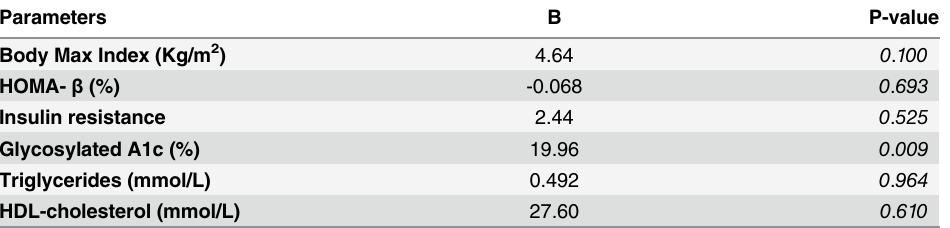
Table 4. Association of fasting serum levels of sCD26/DPP-IV with MetS and A1c levels among type 2 diabetes patients. Parameters B P-value Body Max Index (Kg/m 2 ) 4.64 0 . 100 HOMA- β (%) -0.068 0 . 693 Insulin resistance 2.44 0 . 525 Glycosylated A1c (%) 19.96 0 . 009 Triglycerides (mmol/L) 0.492 0 . 964 HDL-cholesterol (mmol/L) 27.60 0 . 610 The results are presented as unstandardized coef fi cients; B and (P-value) assessed using multiple linear regression adjusted for, age, race, gender, and duration of diabetes. Bold values are signi fi cant. B: coef fi cient for the relationship between the dependent variable “ DPP-IV level ” and the independent variable “ diabetic and metabolic biomarker ” . The positive sign of the coef fi cient implies a direct relationship, and the negative sign implies an inverse relationship.